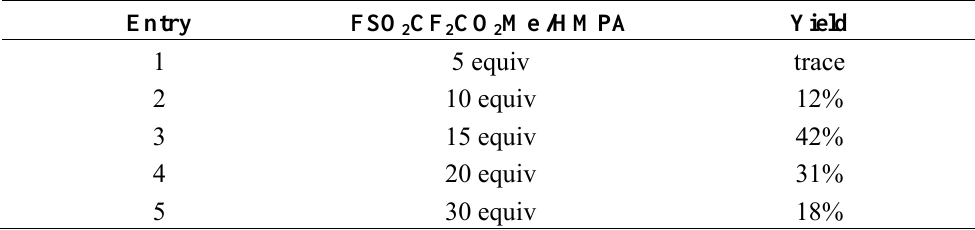
Table 1. Optimization of the reaction conditions of